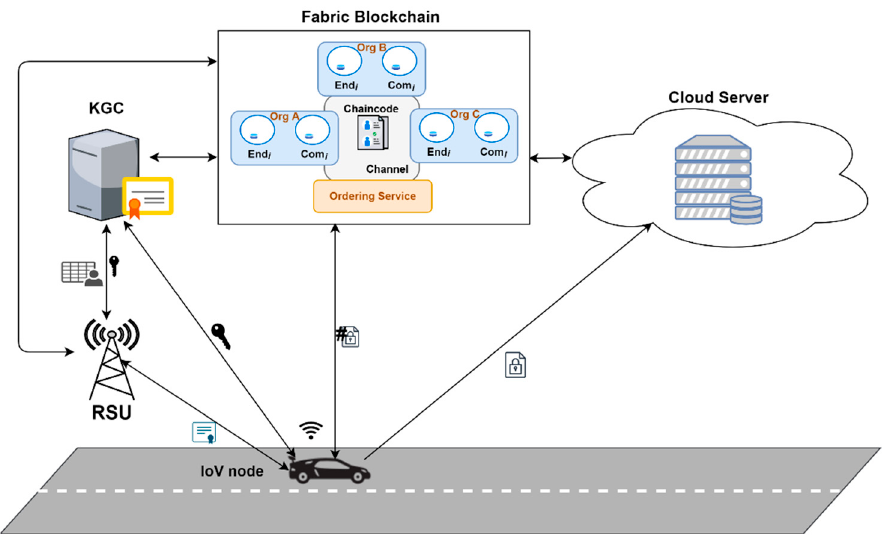
Figure 4. VBlock architecture with key